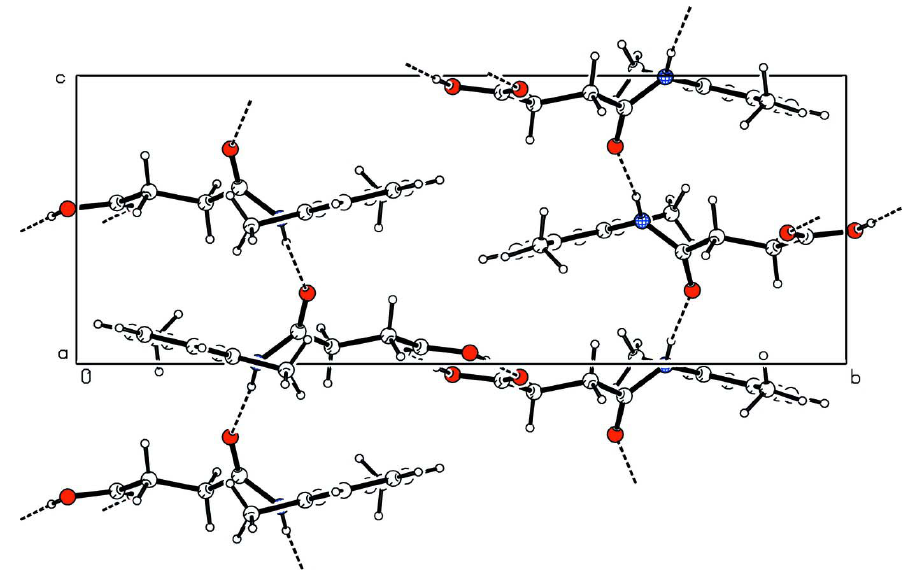
Figure 2 Molecular packing of (I) with hydrogen bonding shown as dashed lines. 3-[(2,6-dimethylphenyl)aminocarbonyl]propionic acid Crystal data H NO C 12 15